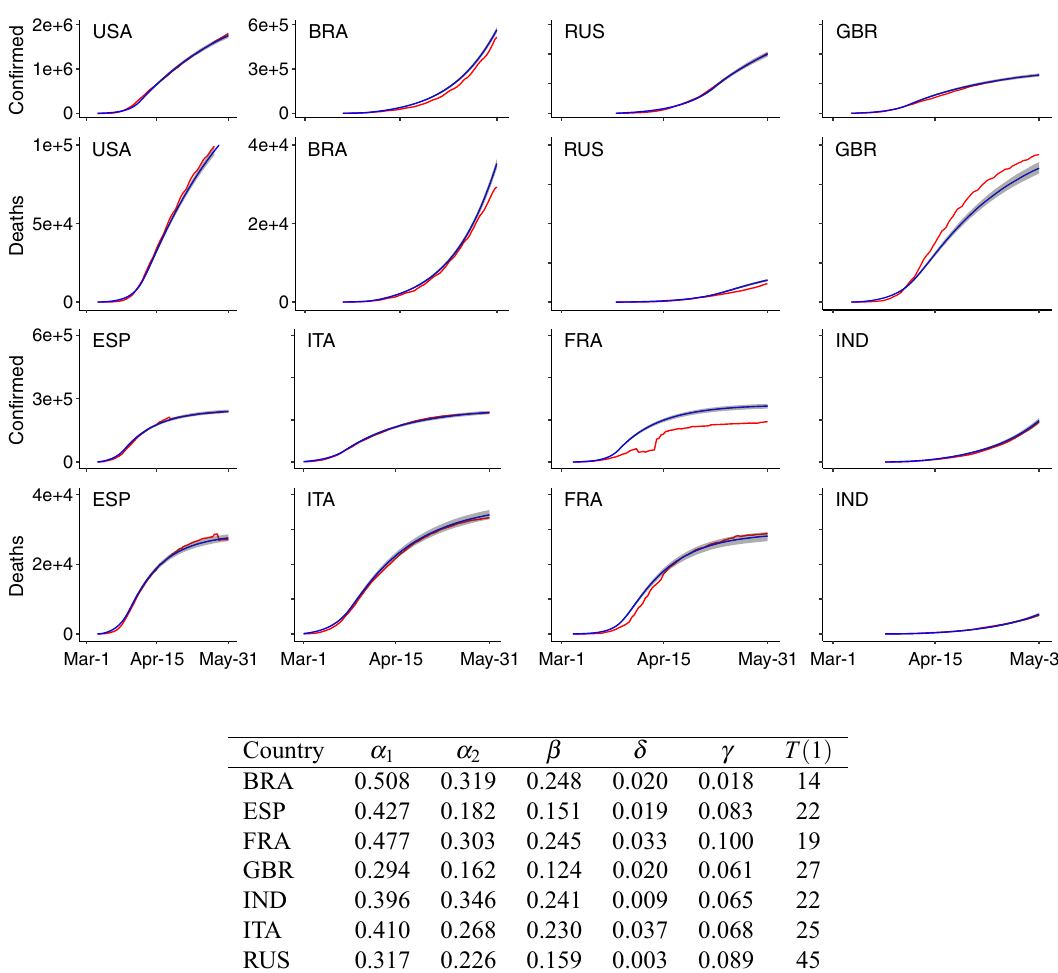
Figure 2. Model fit for different countries. For each country, the fit is demonstrated by the number of accumulated confirmed cases and the accumulated confirmed deaths. In each plot, the red line is the real data, the blue line is the median fitted values, and the shaded region is the 95 % confidence interval. Eight countries are fitted including: the United States of America (USA), Brazil (BRA), Russia (RUS), the United Kingdom (GBR), Spain (ESP), Italy (ITA), France (FRA), and India (IND). Estimated parameter values for the eight countries are as below. Here T (1) is the change point of the transmission rate α , such that α = α 1 when t ≤ T ( 1 ) and α = α 2 when t > T ( 1 ) .